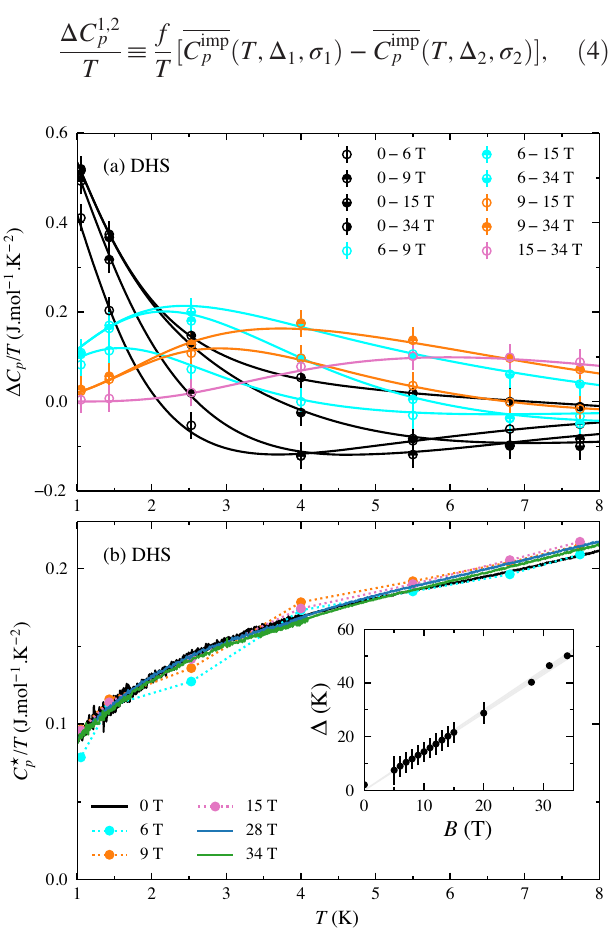
=T allowed by the 16 FIG. 4. (a) Ten of the 120 differences Δ C p data sets of Fig. 2 (DHS single crystal only) and the correspond- ing fitted curves (solid lines) using the phenomenological model of Eq. (4). In panel (b), we show how, once the estimated Schottky-type contributions are subtracted, we get the field- =T ¼ ð C kago p þ C phon p Þ =T . Inset: evolution of the independent C ⋆ p gap Δ , obtained from the latter fits, as a function of the field. The error bars stand for the needed Gaussian broadening σ